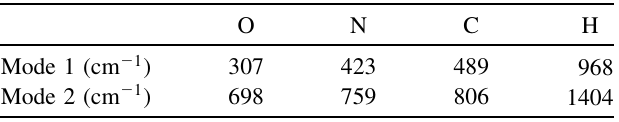
TABLE I. Vibrational modes of interstitial impurity atoms in the bcc niobium lattice from DFT calculations. O, N, and C are located in octahedral lattice interstices and H is in a tetrahedral lattice interstitial